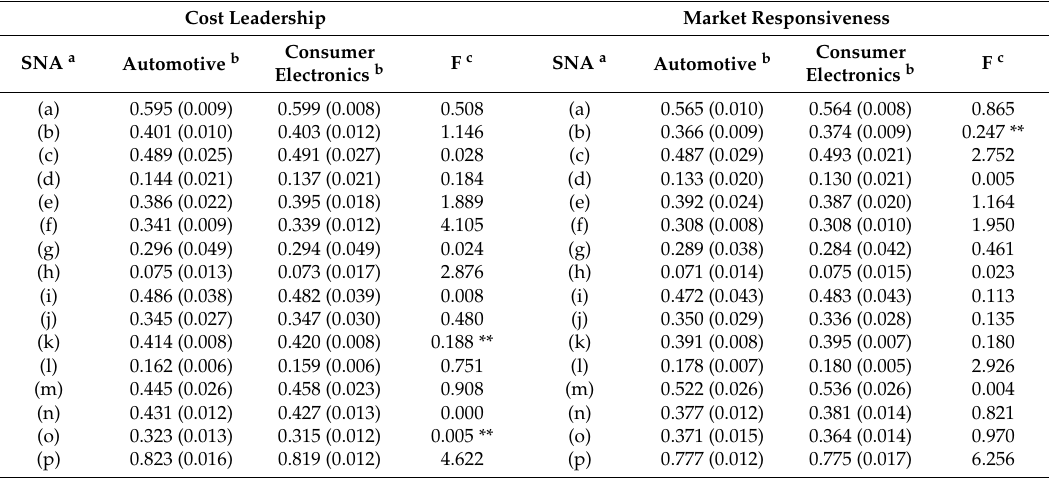
Table 9. Panel 1 comparison